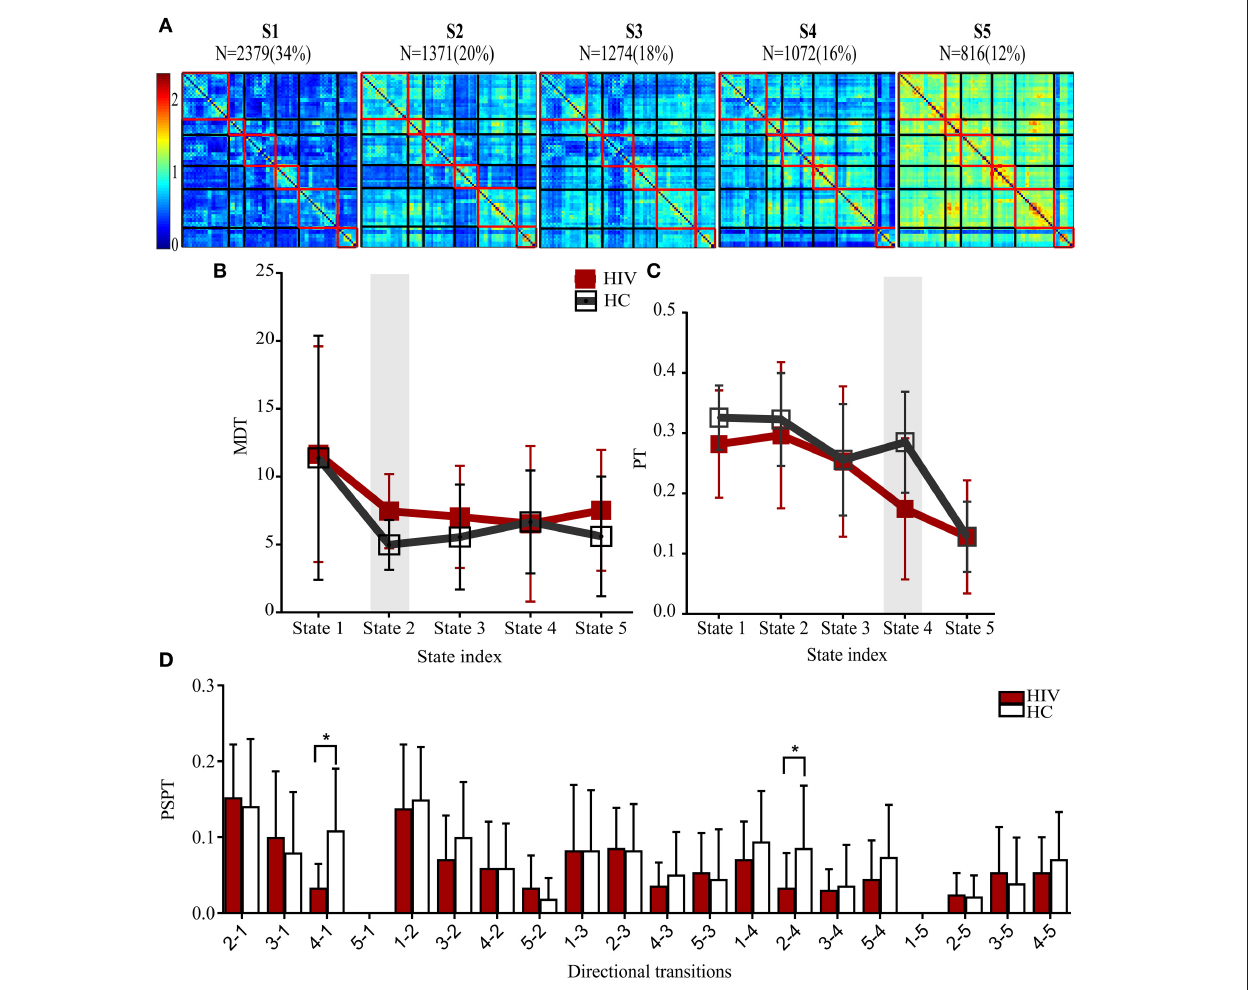
FIGURE 3 | States properties of HIV infected individuals and healthy controls. (A) Five transient states generated by K-means clustering analysis, displayed with the number of correlation maps constituting to the state. (B) Mean dwelling time (MDT) between groups. (C) The probabilities of transitioning (PT) for each state in HIV and HC groups. (D) The probabilities of specific state-to-state transitioning (PSPT). On top of the figures are the numbers ( N = ) of dynamic correlation maps [with their percentages (%)] showing the population of correlation maps assigned to those states during clustering. Group differences (HIV-HC) were significant at p <